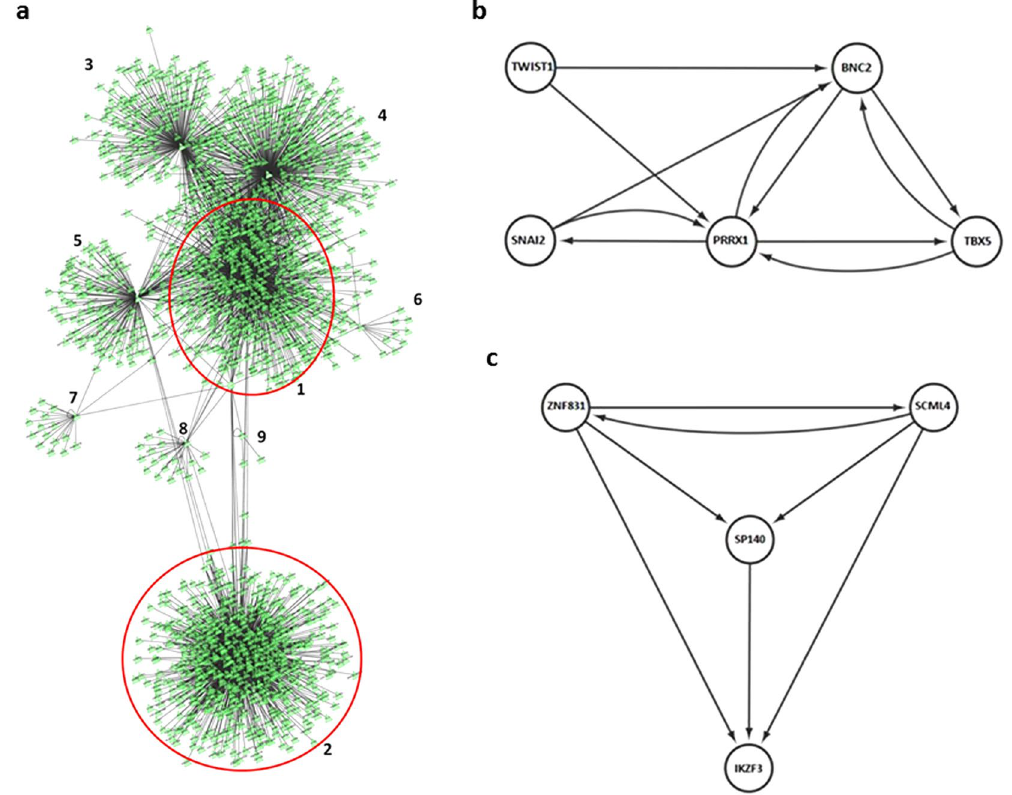
Figure 1. Transcription factor modules. ( a ) - Graphical representation of the regulons of the 17 Transcription Factors in the NACT dataset Inferred by ARACNE algorithm. Regulons: 1 – SNAI2, TWIST1, PRRX1, BNC2, TBX5, 2 – SCML4, ZNF831, SP140, IKZF3, 3 – ID4, 4 – HOXA5, 5 – ZNF503, 6 – TSC22D1. 7 – HOXB3, 8 – CREB3L1, 9 – GATA6. The Regulon of FOXF2 has 32 genes, these genes are shared by the regulons of SNAI2, TWIST1, PRRX1, BNC2, TBX5, ID4 and HOXA5 and are not identifiable in the figure. Green triangles represent genes, the lines linking them represent a relationship between the expression of them. ( b ) - Mesenchymal Transcription Module and ( c ) - Immune Response Transcription Module. Master regulators of the bCSC phenotype inferred by MRA-FET in the bCS/CC